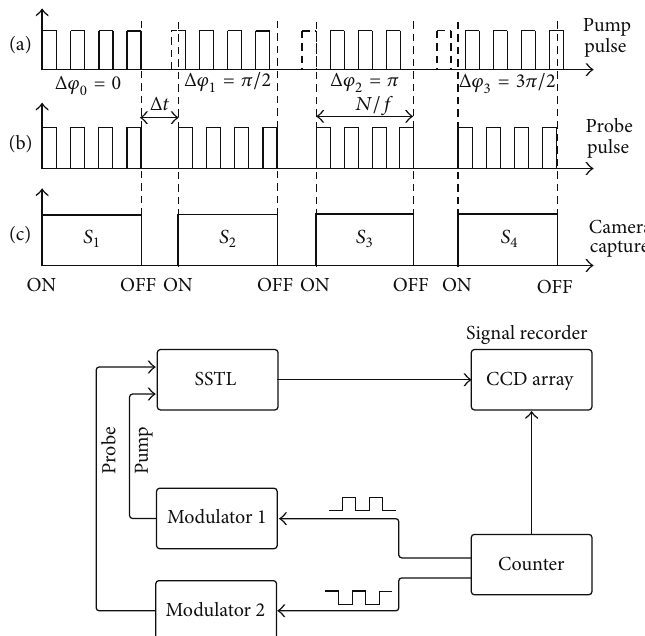
Figure 3: Pulse sequence of double-modulation of four-point correlation for stroboscopic surface thermal lensing.